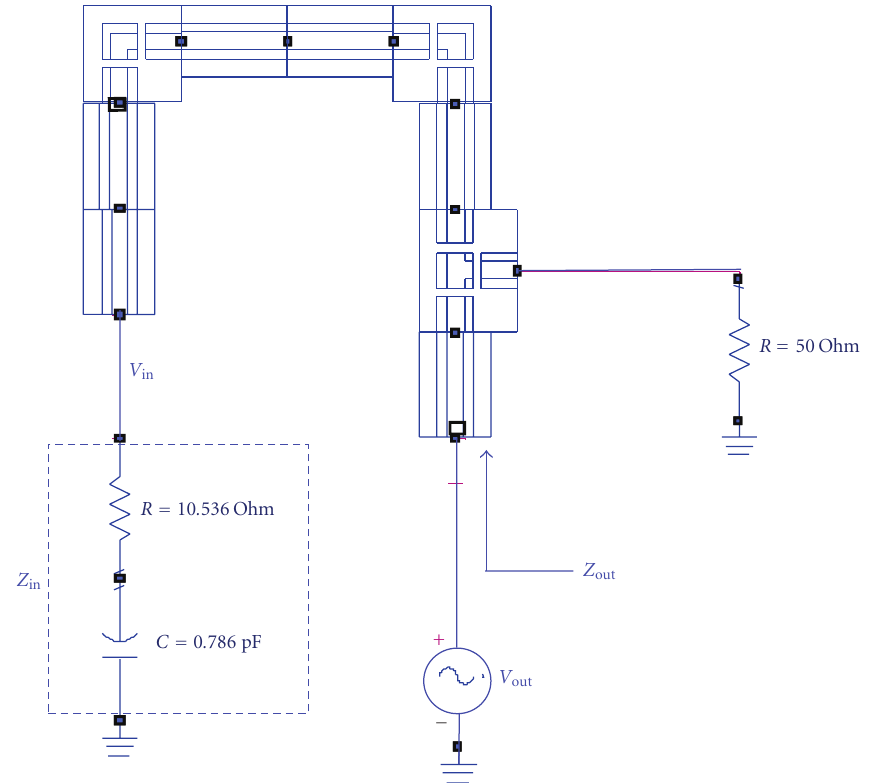
Figure 14: Feedback loop circuit.